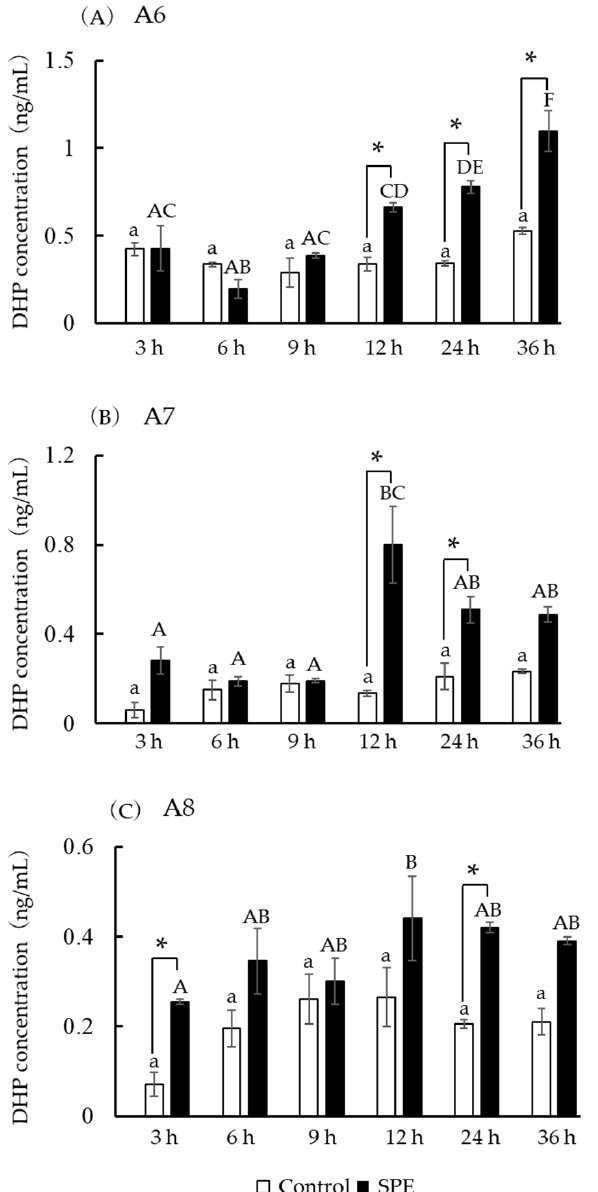
Figure 8. DHP concentration in the medium after different incubation periods. Concentrations of DHP in the medium after incubation: ovarian follicles collected 8 h after the first LHRHa injection were incubated with 500 µ g/mL SPE (black column). ( A – C ) indicate the level in individuals A6, A7, and A8, respectively. Each vertical bar represents the mean ± SE of 3 replicate incubations. Different letters (control: a, SPE: A) represent a significant difference among groups ( p < 0.05). * p < 0.05.